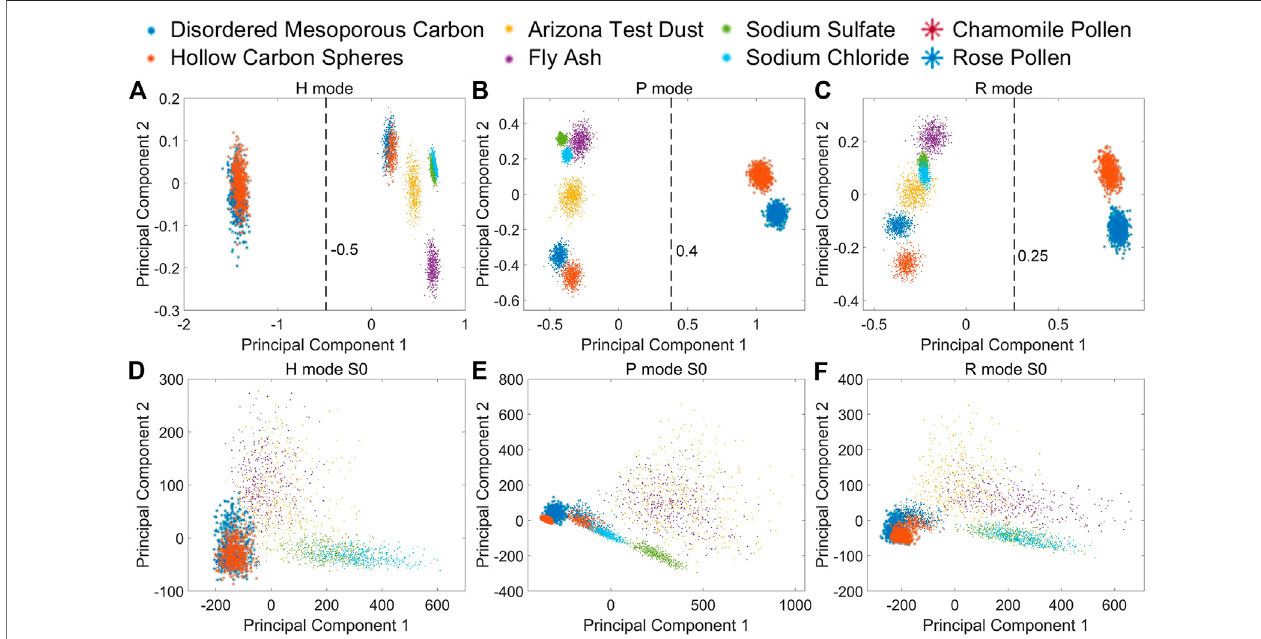
FIGURE 3 | Pollen and non-biological samples on PCA fi rst and second principal component. (A) MAPIS under H mode; (B) MAPIS under P mode; (C) MAPIS under R mode. (D) S 0 at four angles under H mode; (E) S 0 at four angles under P mode; (F) S 0 at four angles under R mode.